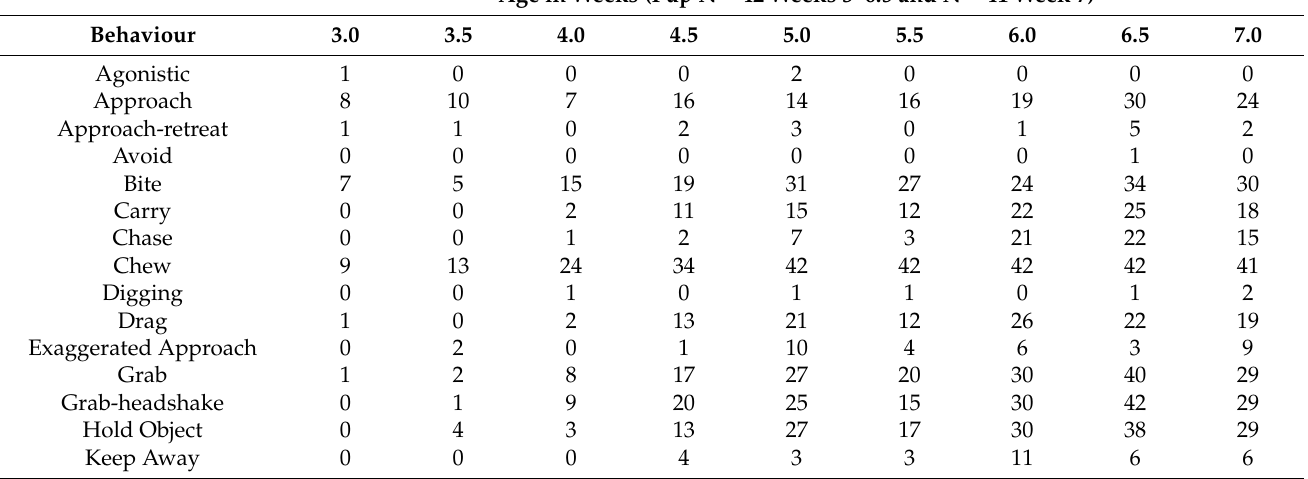
Table 4. Number of pups performing behaviors by age. Number of pups (out of 42 total) that performed each behavior at least once at each week (7 litters and 3 breeds combined) from weeks 3–7. Note that at week 7, the total number of pups was 41 due to one pup being rehomed that